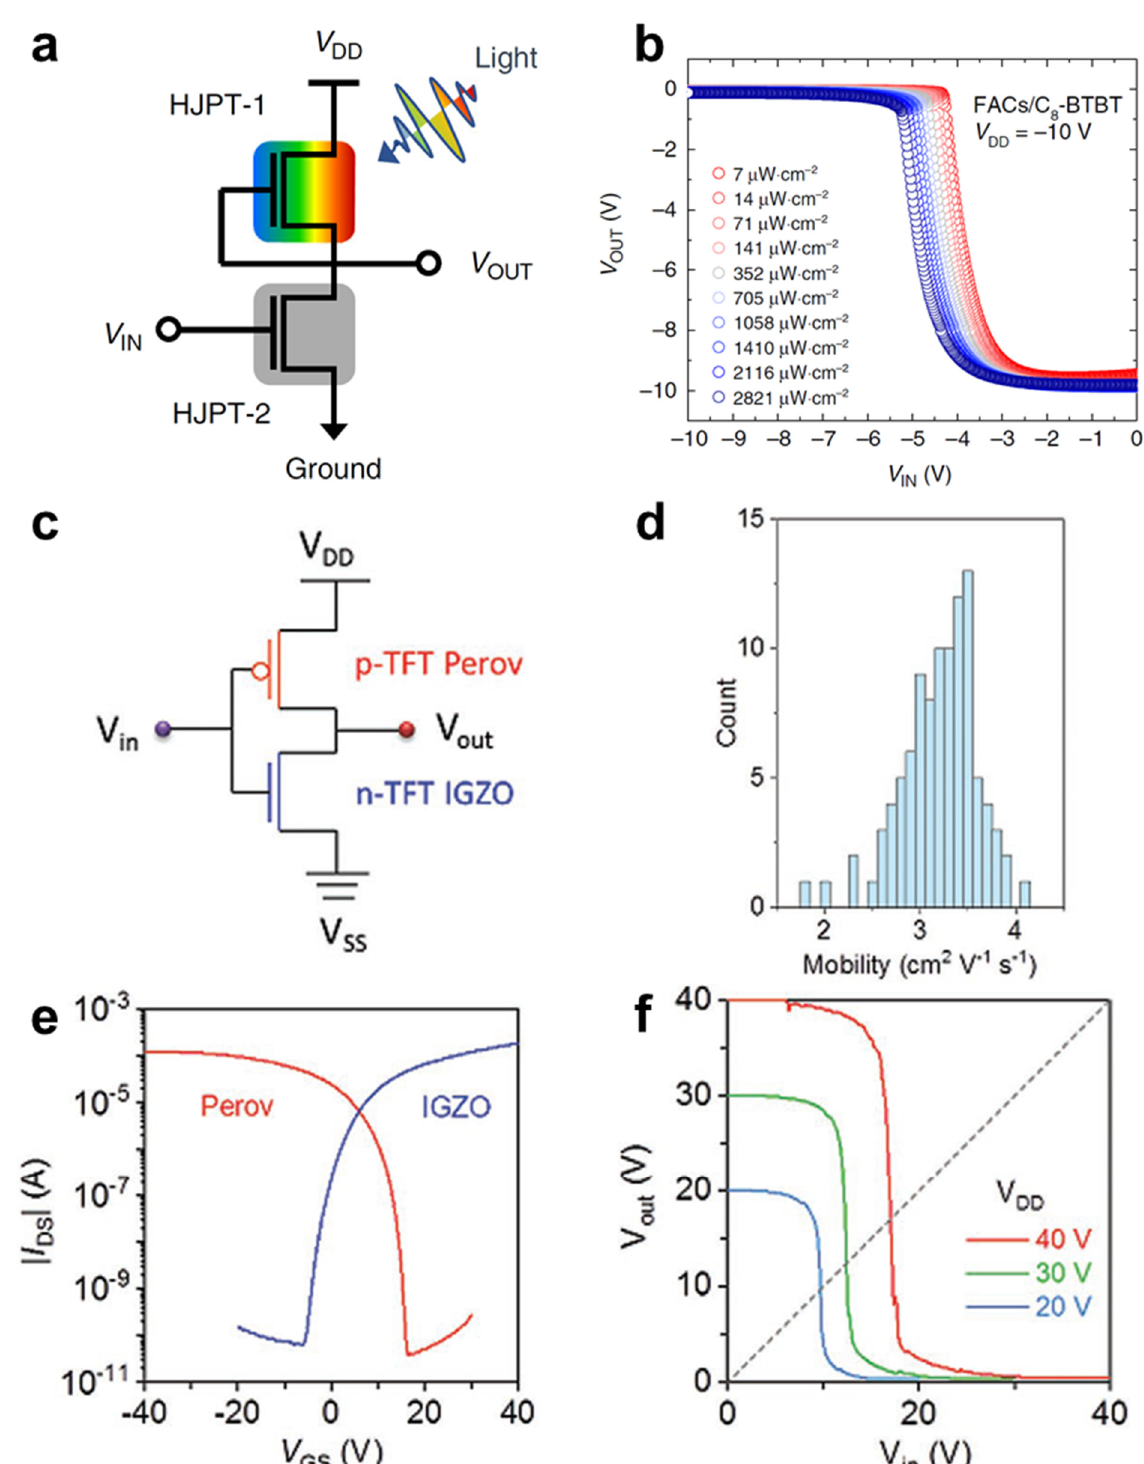
Figure 4. ( a ) Transfer characteristics for heterojunction phototransistor (HJPT) photo-inverters. ( b ) Transfer characteristics measured using a 475 nm LED light source under different incident light intensities for photo-inverters composed of HJPTs using FACs/C8-BTBT (adapted from [98] with permission from Springer Nature). ( c ) Circuit diagram of a (PEA) 2 SnI 4 TFT array on a four-inch Si/SiO 2 (100 nm) wafer substrate. ( d ) Statistical distribution of mobility obtained from 100 TFTs across the array. ( e ) Transfer characteristics of perovskite and IGZO TFTs. ( f ) VTC of a complementary inverter at different V DD values (adapted from [99] with permission from John Wiley and Sons).